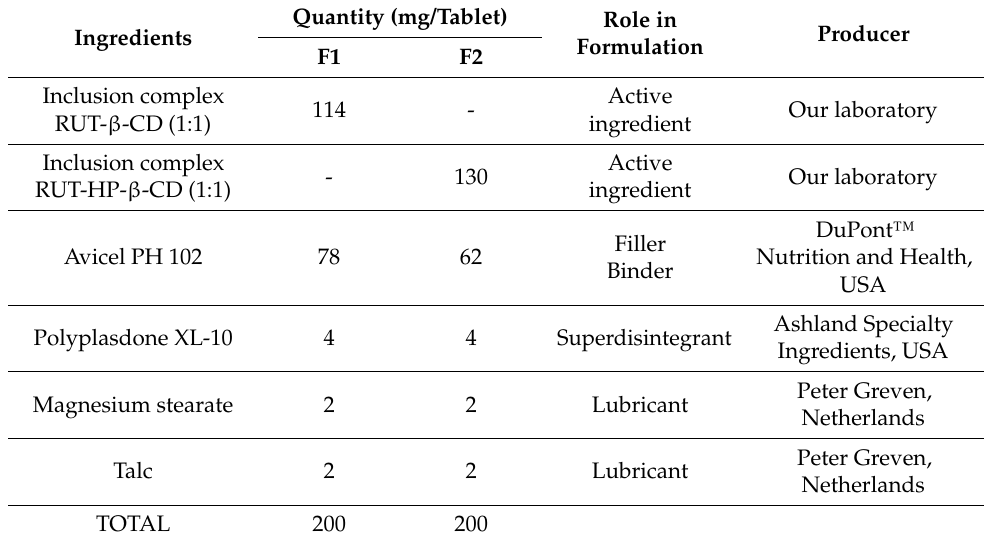
Table 1. The formulations of the tablets with RUT- β -CD and RUT-HP- β -CD inclusion